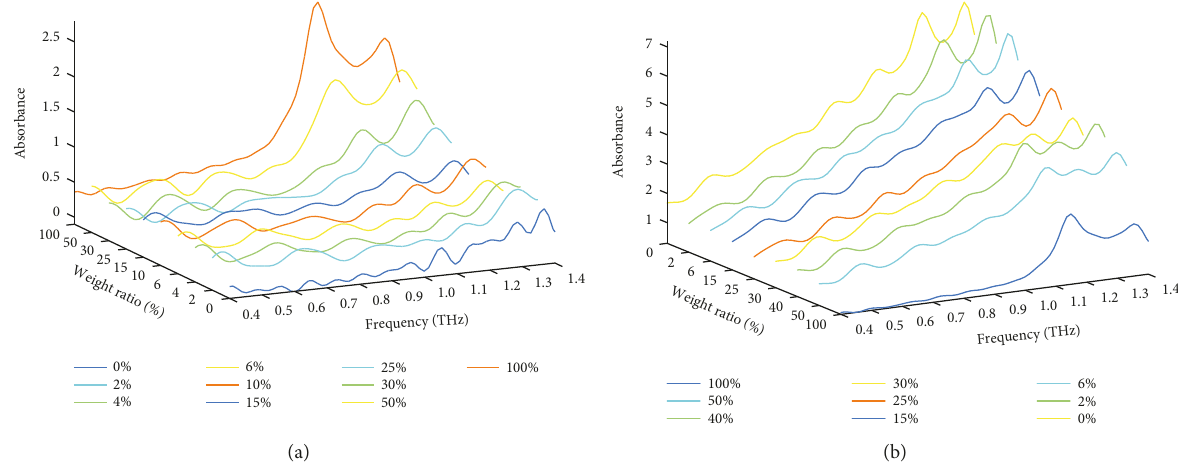
Figure 3: Average absorbance spectrum of mixtures wrapped in paper. (a) Carbendazim and polyethylene mixture. (b) Carbendazim and rice powder mixture.